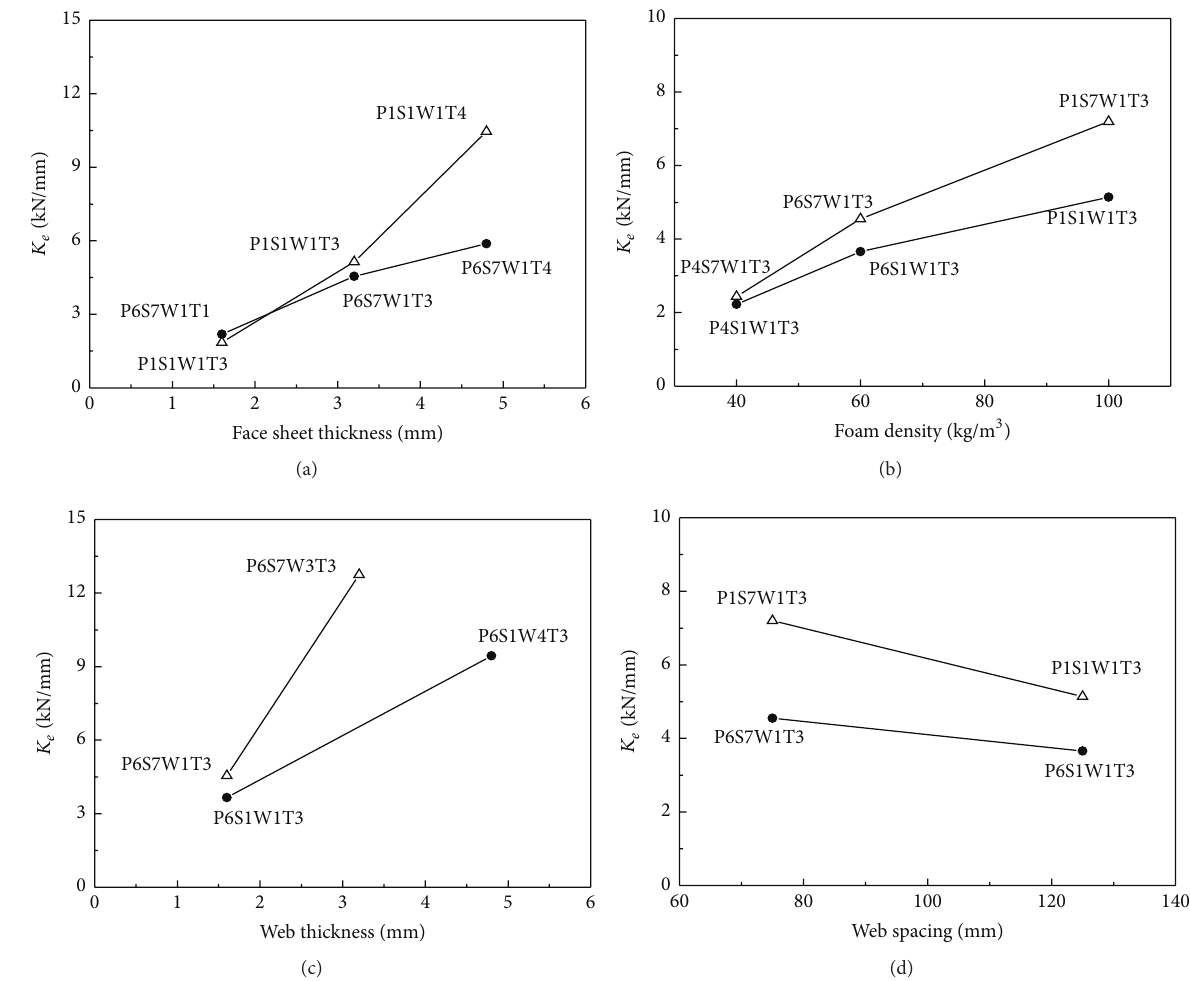
Figure11:Initialbendingstiffness:(a)theinfluenceoffacesheetthickness,(b)theinfluenceoffoamdensity,(c)theinfluenceofwebthickness, and (d) the influence of web